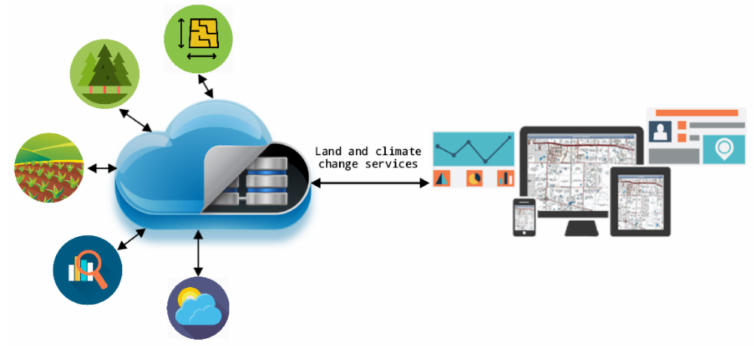
Figure 4. The overview of Mountain Community Adaptive System